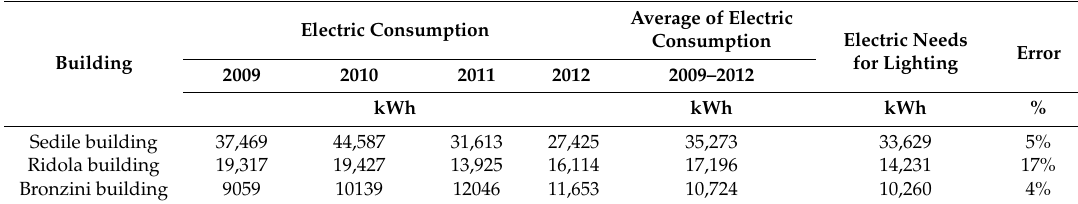
Table 12. Comparison between electricity consumption measured and simulated.